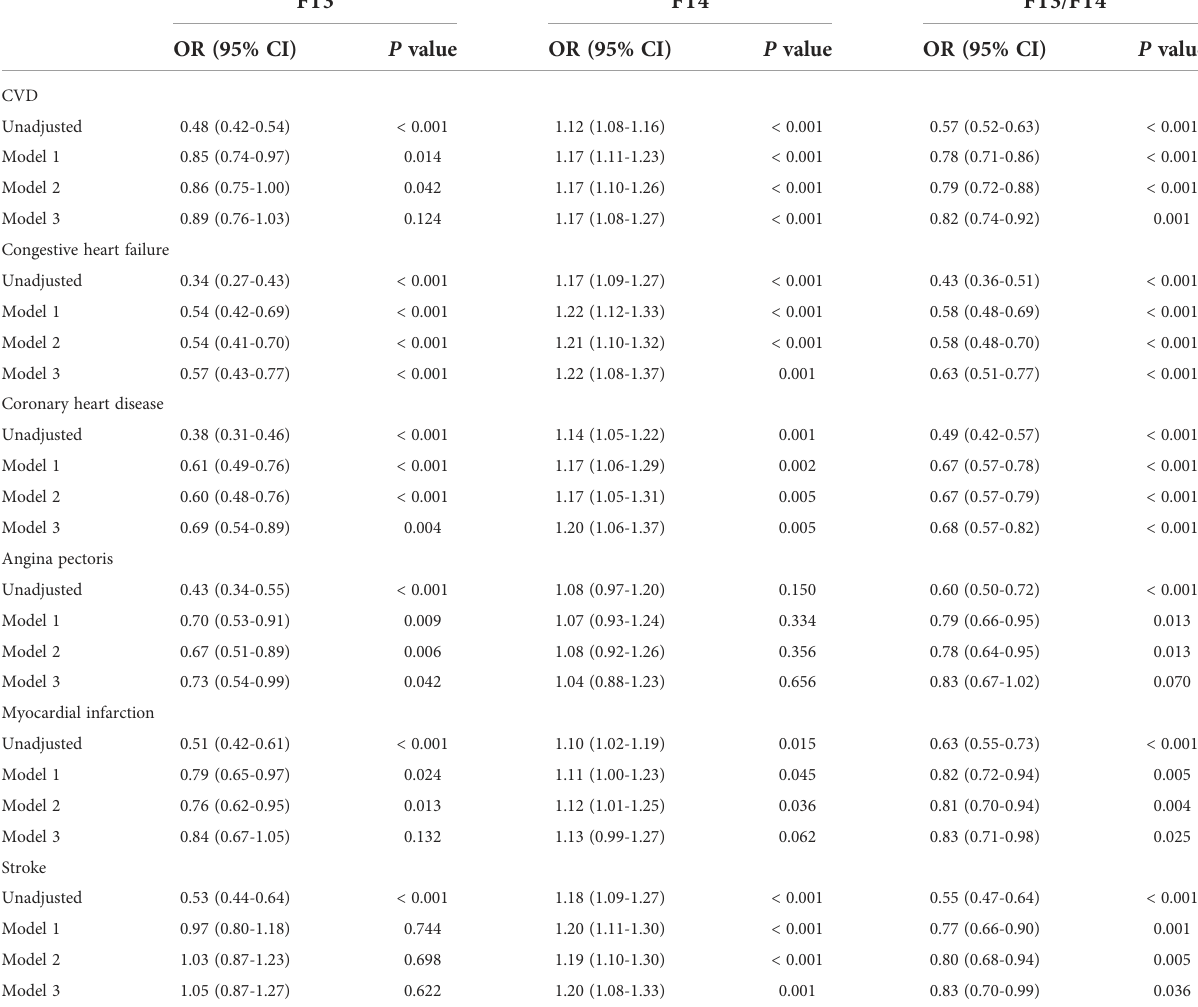
FT3, free triiodothyronine; FT4, free thyroxine; CVD, cardiovascular diseases. Model 1: adjusted for age (6 groups) and sex (male or female). Model 2: further adjusted for race/ethnicity (Mexican American, non-Hispanic white, non-Hispanic black or other), education (< high school, high school/GED or > high school), marital status (married/living with partner, divorced/widowed/separated, or never married), serum cotinine (> 10, LOD-10 or < LOD ng/mL), alcohol drinking (yes or no). Model 3: further adjusted for BMI (< 25, 25-29.9 and ≥ 30 kg/m 2 ), hypertension (yes or no), diabetes (yes or no), hypercholesterolemia (yes or no), renal impairment (yes or no), family history of CVD (yes or no), history of cancer (yes or no), and history of liver impairment (yes or no), TSH (continuous), TPOAb (continuous), TgAb